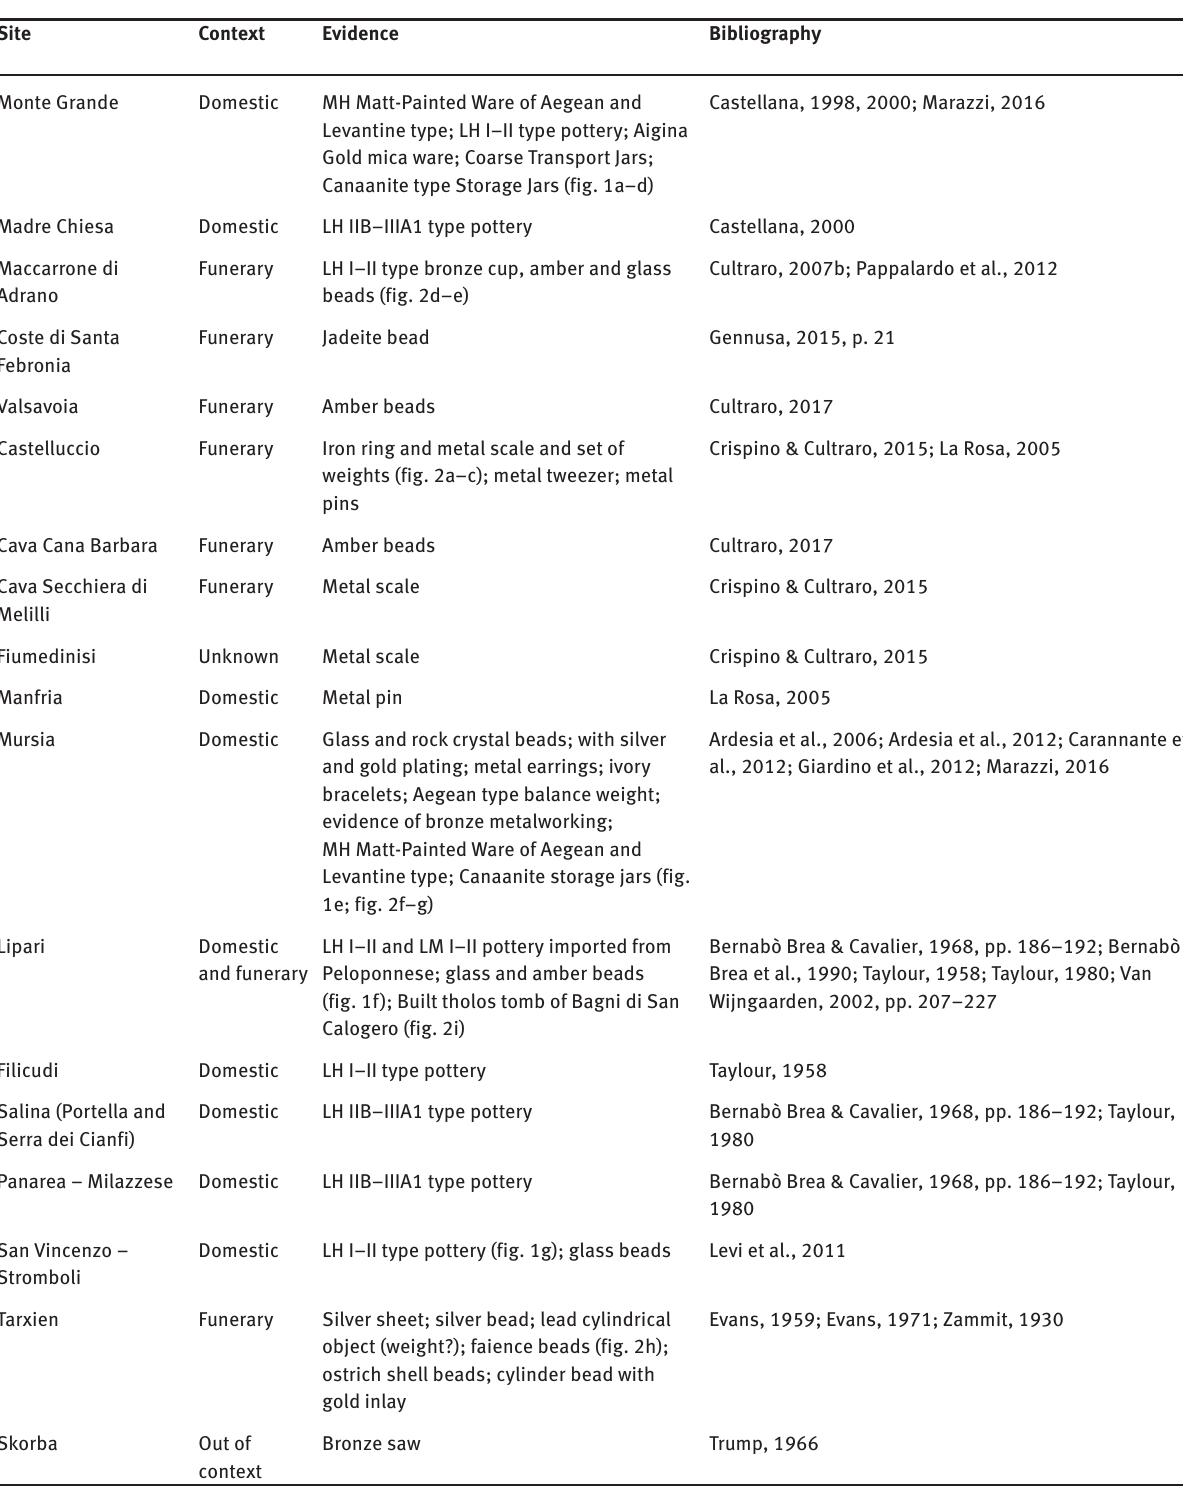
Table 2: Materials of Aegean Origin in Early Bronze Age Sicily and Malta.